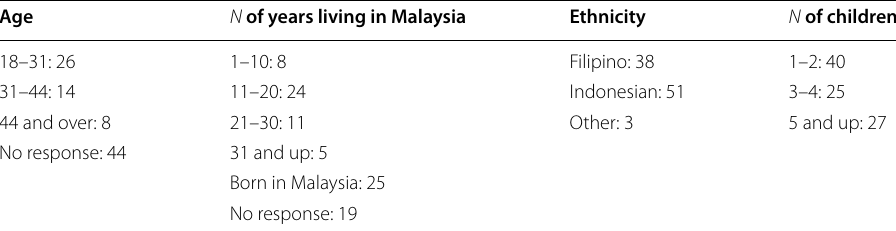
Table 2 Descriptive statistics of mothers ( N